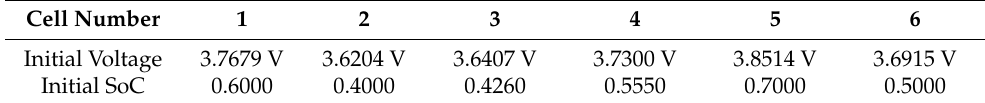
Table 5. Initialization of tested cells.